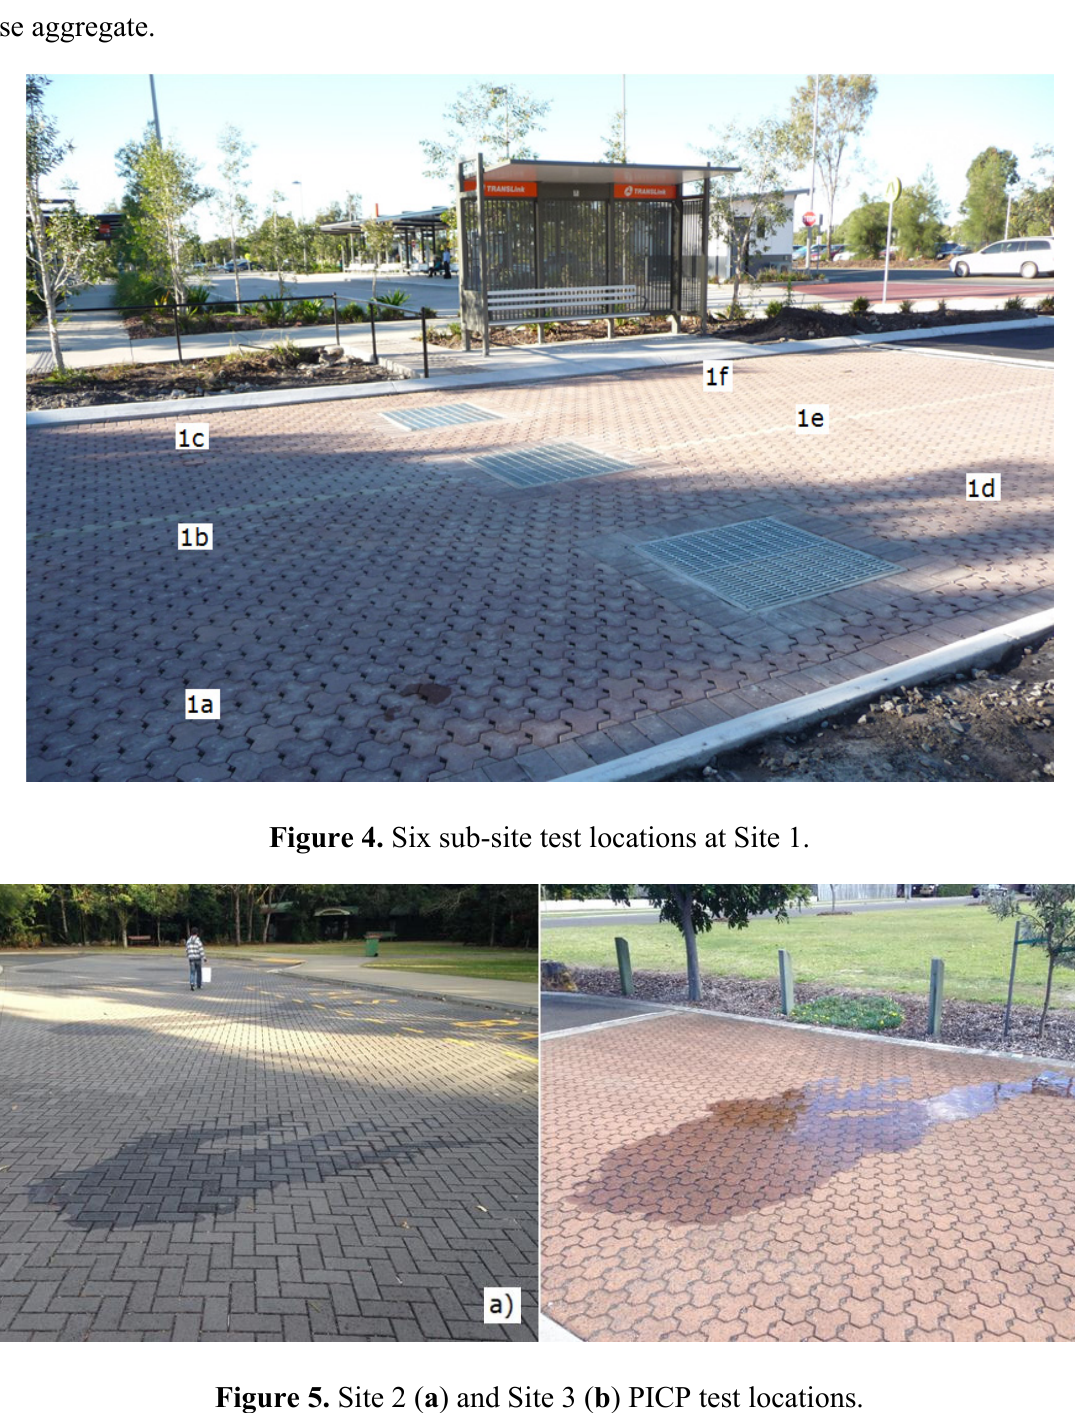
Figure 5. Site 2 ( a ) and Site 3 ( b ) PICP test